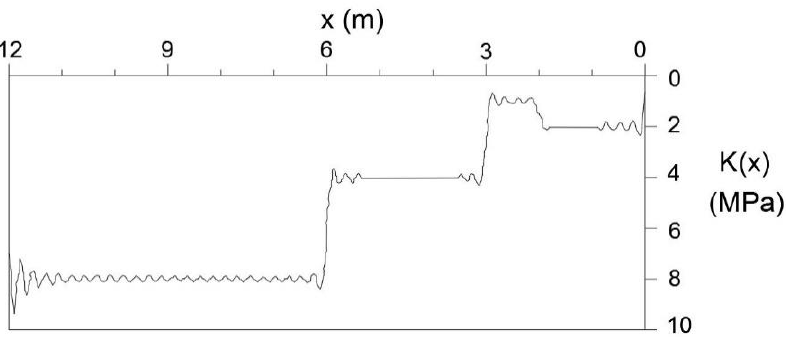
Figure 4. Development of Fourier series with 100 terms of the function K (x) of soil with four layers (K 1 = 2 MPa, K 2 = 1 MPa, K 3 = 4 MPa, K 4 = 8 MPa).